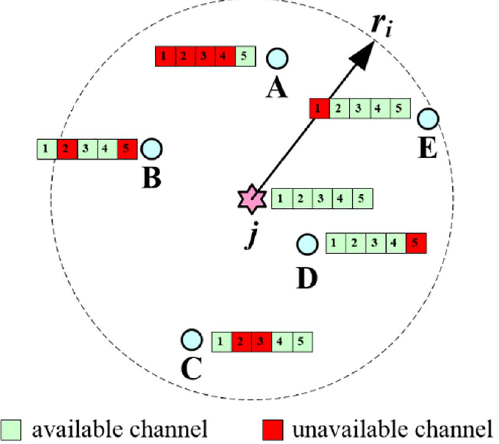
Figure 3. Example of acquiring parameters for ETBCHs